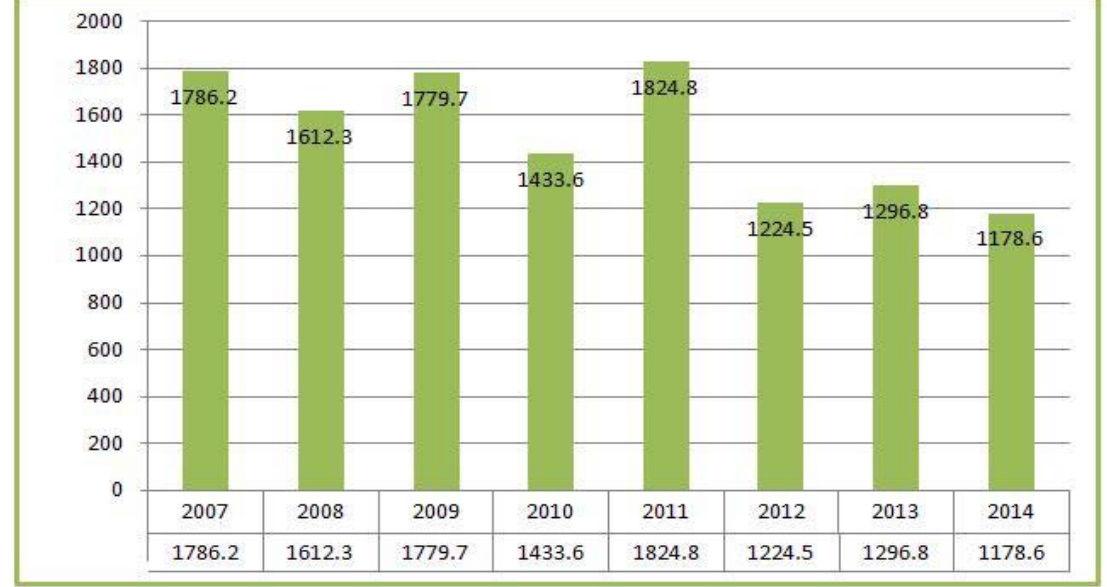
Climate 2016 , 4 , 58 Figure 3. Annual precipitation (mm) in Rasht County. Figure 3. Annual precipitation (mm) in Rasht County.